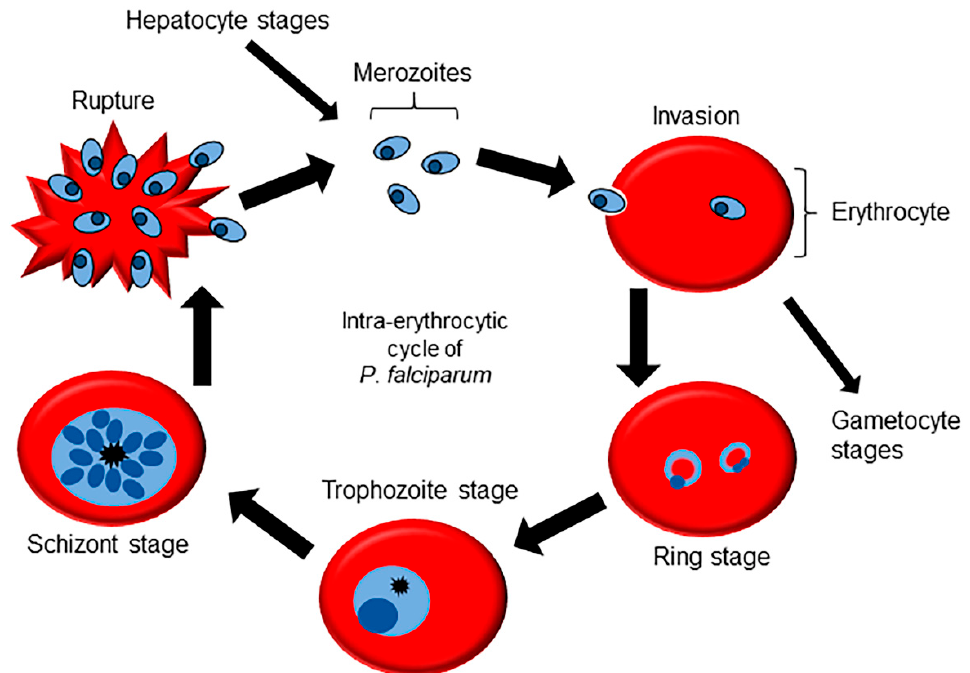
Figure 1. Schematic figure of the intraerythrocytic cycle of P. falciparum . Merozoites from the liver stages are released into stages are released into the bloodstream and invade the erythrocytes, differentiating into the bloodstream and invade the erythrocytes, differentiating into rings. The ring stage grows in volume taking advantage of the abundance of nutrients until it becomes a trophozoite, at which stage the metabolic activity is high and DNA repli- cation begins. The development is completed in the schizont stage, where it is possible to notice several nuclei that will later segment into new merozoites. The mature merozoites rupture the RBC and are released into the bloodstream ready to invade new cells and complete the cycle. A small portion of the merozoites that invade the cells differentiate into ga- metocytes, which, over 14 days, complete the development and are able to infect mosquitoes.